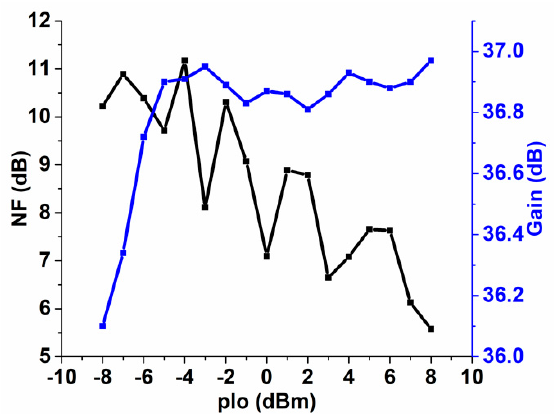
Figure 18. The measured NF (noise figure) and gain.